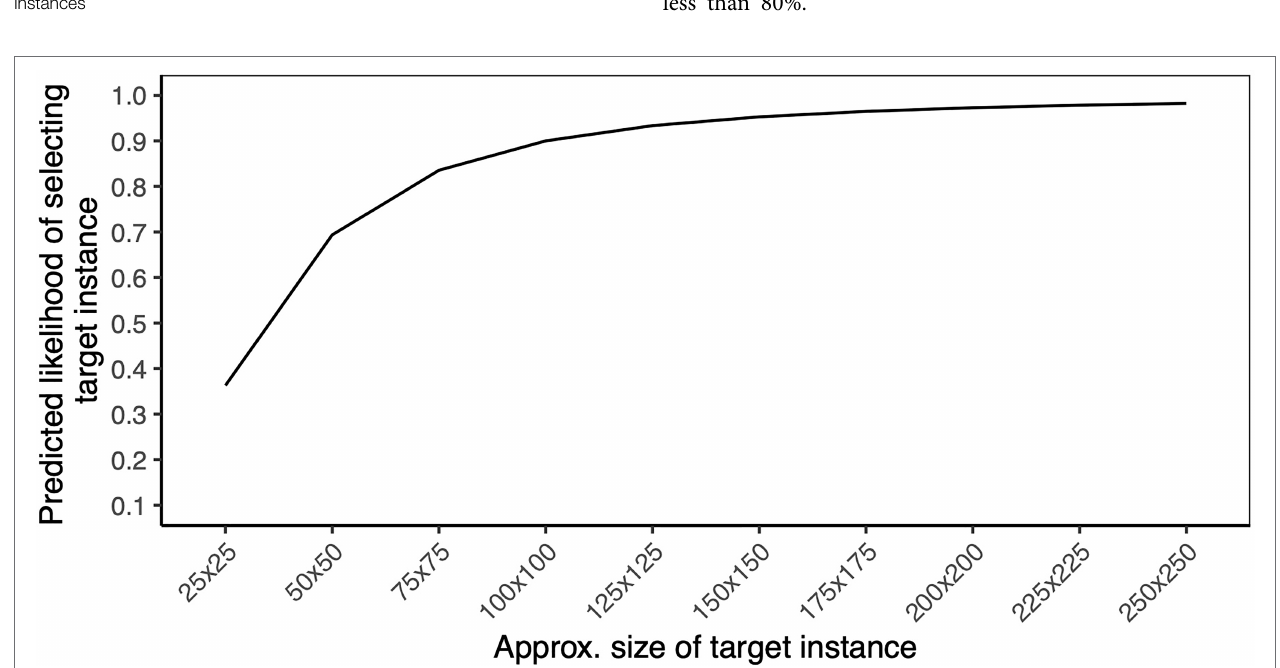
FIGURE 3 | Likelihood of identifying target instance, by